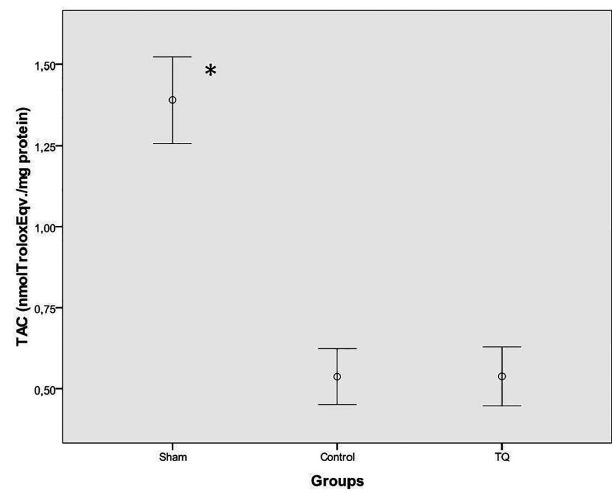
Fig. 1 - TAC levels for sham, control, and thymoquinine groups. * P<0.001 (for all comparisons) compared with I/R and I/R+TQ